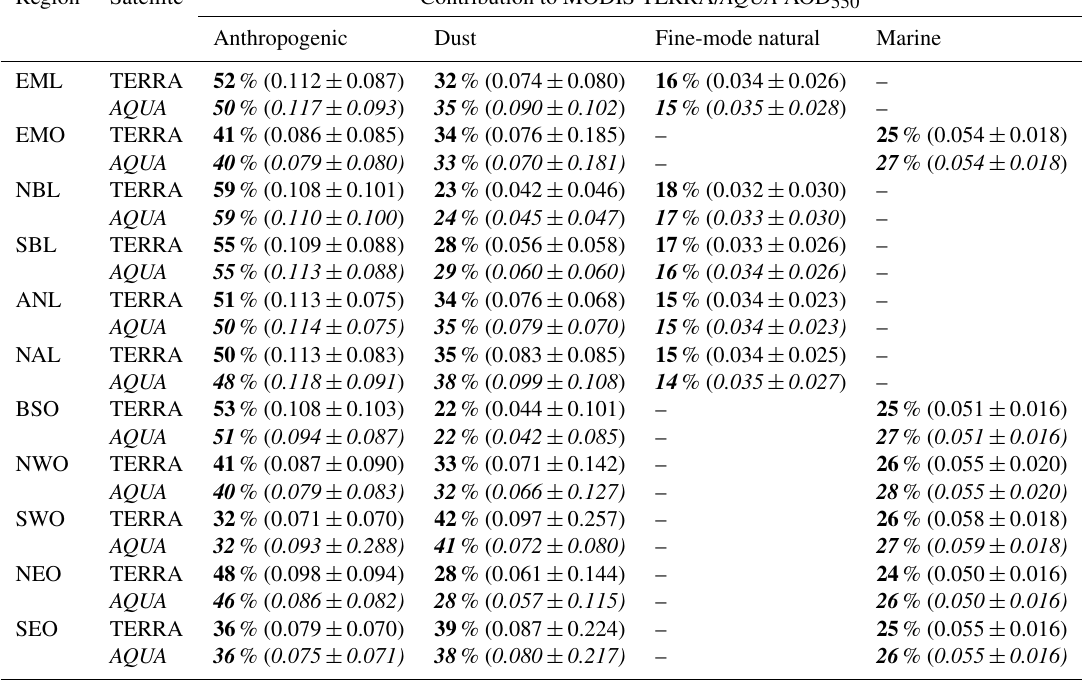
Table 4. Relative contribution of anthropogenic aerosols, dust, fine-mode natural and marine aerosols to the total AOD 550 (bold) and the corresponding τ a , τ d , τ n and τ m levels with their ± 1 σ values (in parentheses) over the Eastern Mediterranean (EMT), over the land-covered part (EML), over the oceanic part and over the nine subregions of the Eastern Mediterranean appearing in Fig. 1 based on the MODIS Terra and Aqua (italics) observations. The sum of the aerosol type AODs per region does not necessarily correspond to the total AOD 550 values appearing in Table 3 as these results were for the total of the days with aerosol retrievals, even for days when our aerosol type separation algorithm was not